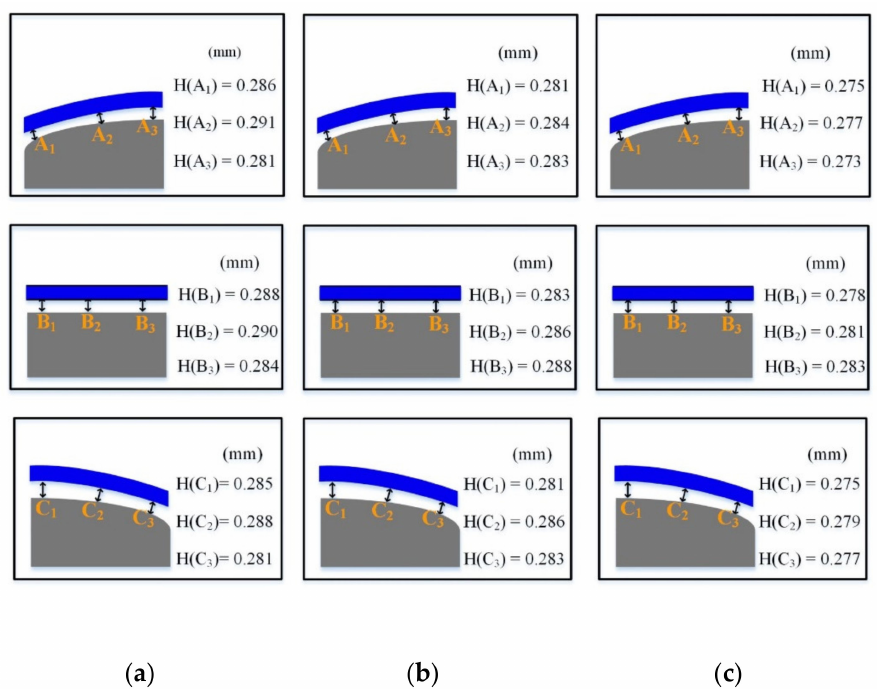
Figure 12. Shape deviation of final glass device; ( a ) the bending temperature is 610 ◦ C and the average gap is 0.2860 mm; ( b ) the bending temperature is 640 ◦ C and the average gap is 0.2839 mm; ( c ) the bending temperature is 670 ◦ C and the average gap is 0.2776